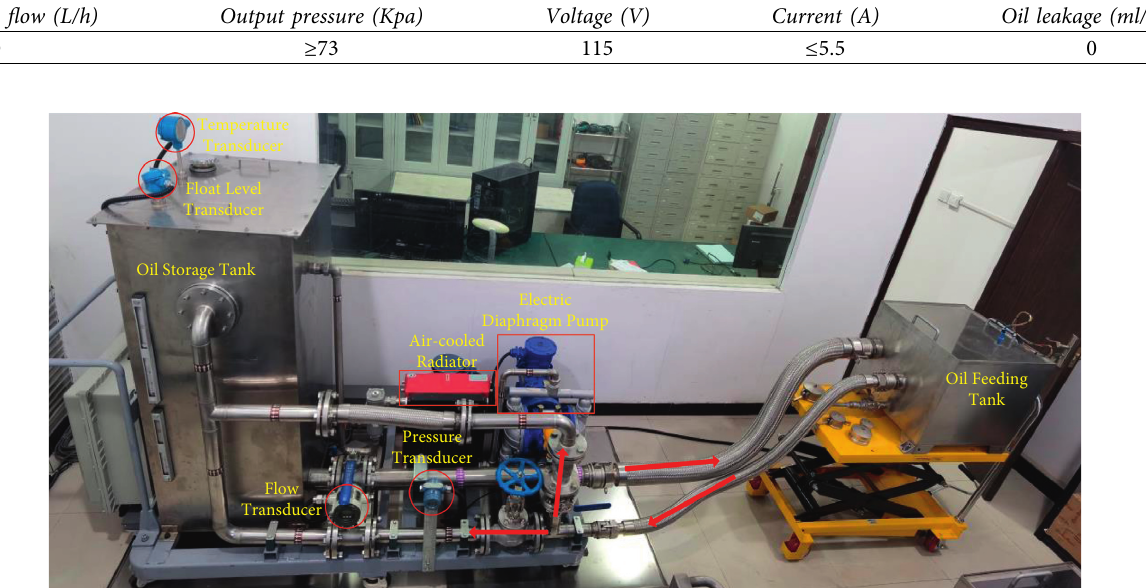
Figure 7: Structure diagram of a certain type centrifugal airborne fuel pump. Table 1: Main working parameters of the airborne fuel pump.